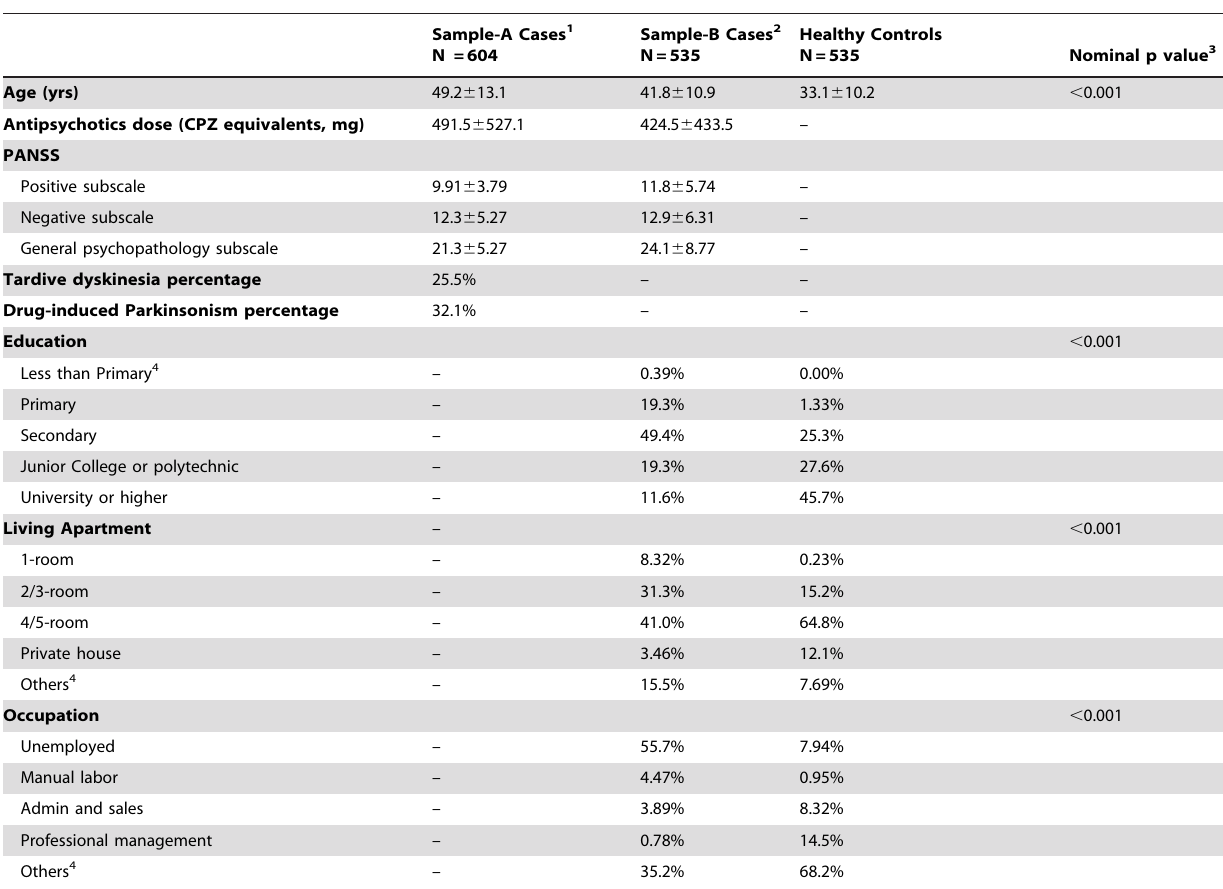
Table 1. Descriptive statistics of the three independent study